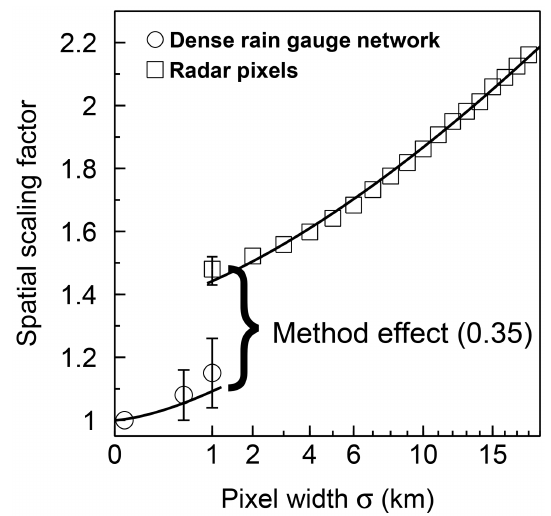
Figure 3. Spatial scaling factors for long-term average annual R . Open circles result from rain gauges aggregated to pseudo-radar pixels. Open squares result from radar and aggregation of radar data. Error bars represent the 95% confidence interval. Lines denote a multiple regression (see text). The x axis is square-root-scaled to improve visibility at low pixel